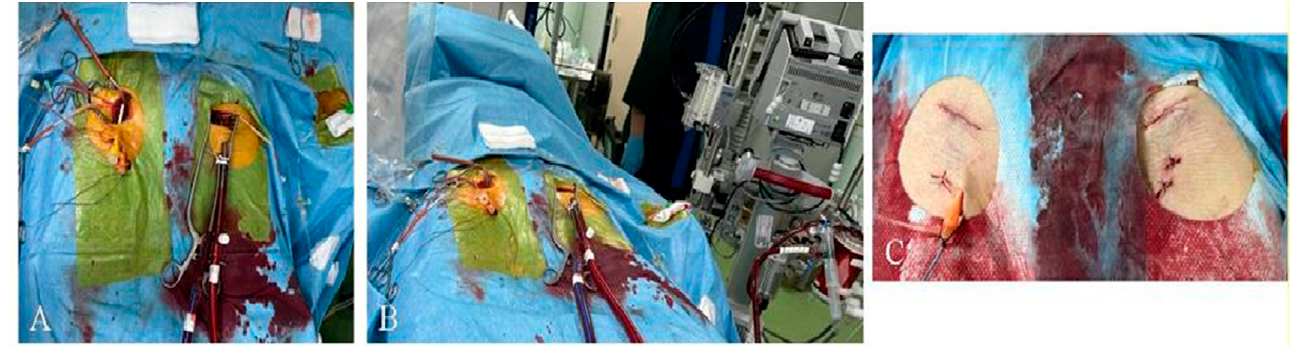
Figure 2. Mini-cutdown open technique for V-AECMO and TAVR cannulation. ( A , B ) intraproce- dural view of running V-A ECMO; ( C ) final view of accesses for ECMO and